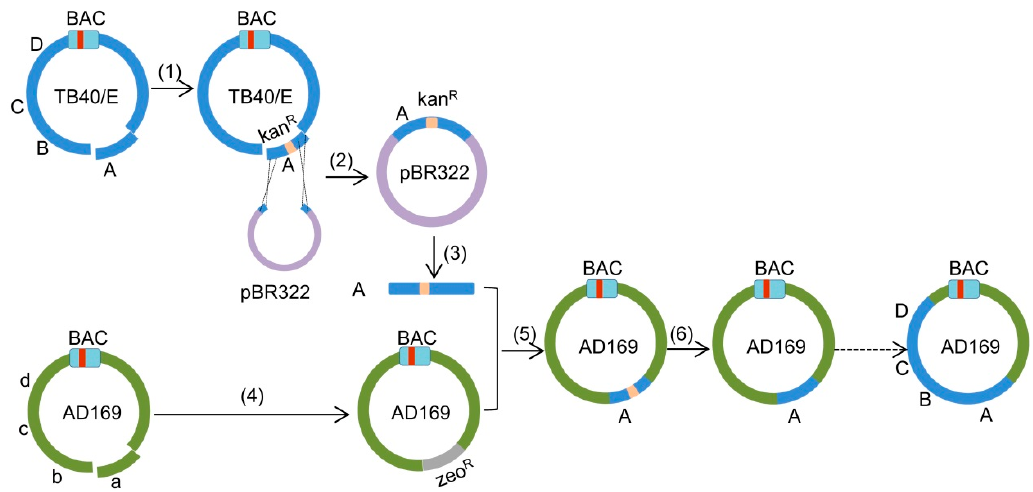
Figure 1. Schematic view of the copy-paste mutagenesis. (1) Insertion of a kan R /I-SceI cassette into fragment ‘A’ (UL112-127) of TB40/E by Red recombination, corresponding to the first step of en passant mutagenesis. (2) Copying of fragment ‘A-Ins’ into pBR322 by gap repair recombination. (3) Release of fragment ‘A-Ins’ from plasmid by restriction enzyme digestion. (4) Deletion of fragment ‘a’ (corresponding to fragment A in TB40/E) in AD169 by Red recombination. (5) Insertion of fragment ‘A’ into AD169-Del by Red recombination. (6) Removal of the kan R /I-SceI cassette by Red recombination, corresponding to the second step of en passant mutagenesis. The red bar within the bacterial artificial chromosome (BAC) cassette represents the chloramphenicol resistance (cam R ) marker.